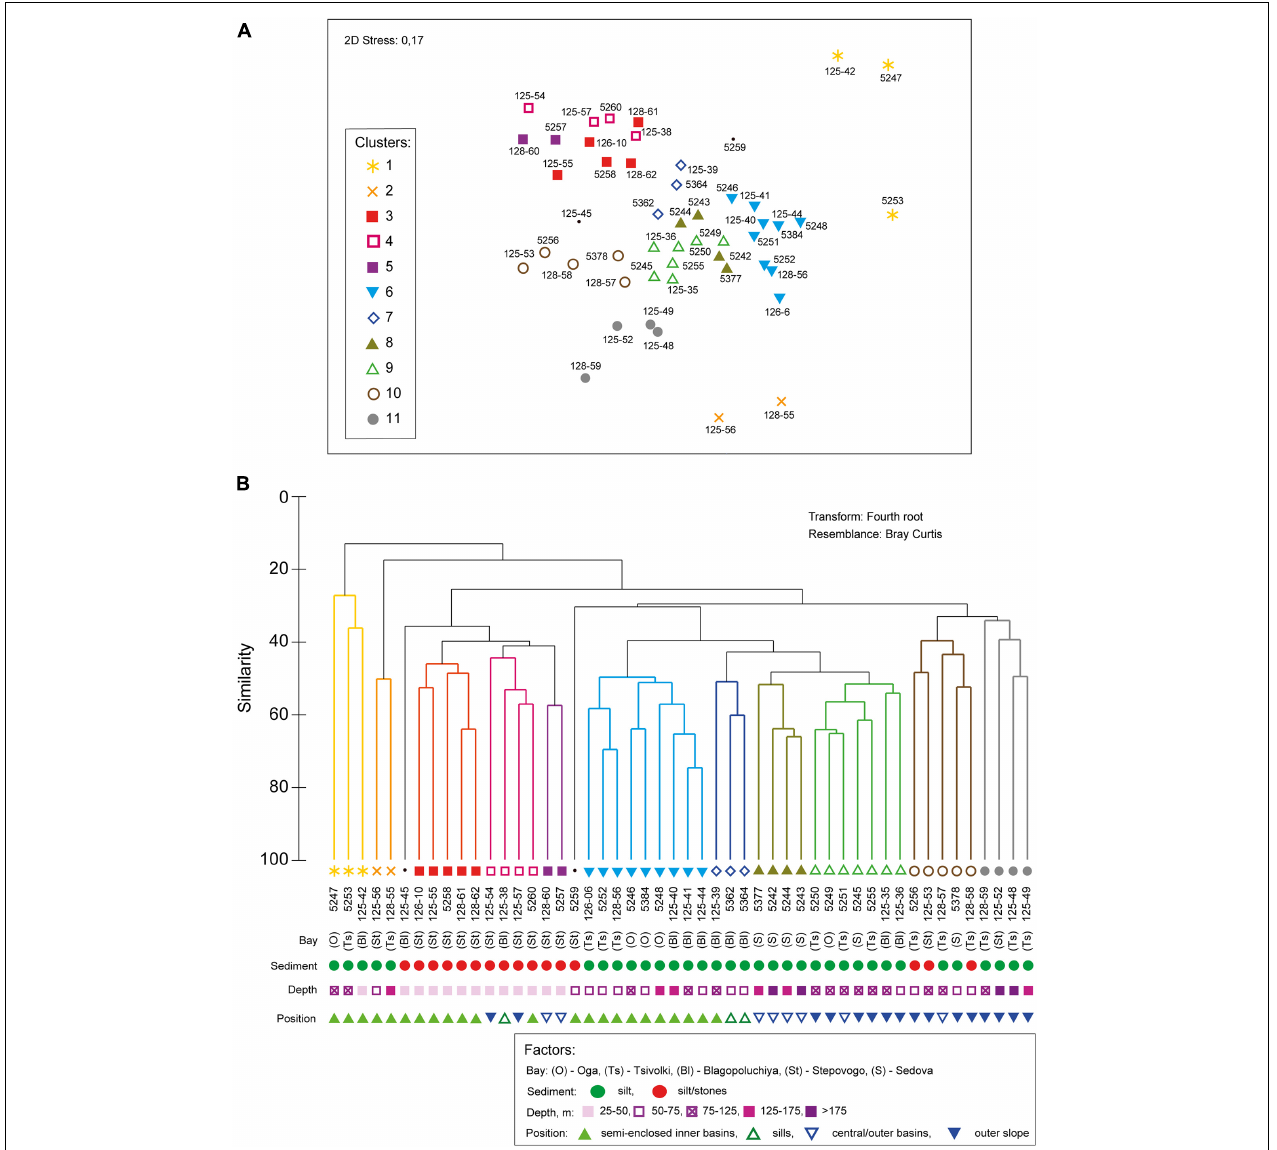
FIGURE 3 | The results of (A) nMDS ordination diagram and (B) hierarchical clustering (UPGMA) estimated using Bray–Curtis similarity index based on species respiration rates data. The clusters significant at 0.05 level (SIMPROF test) are indicated by colors. Environmental parameters are indicated by symbols.